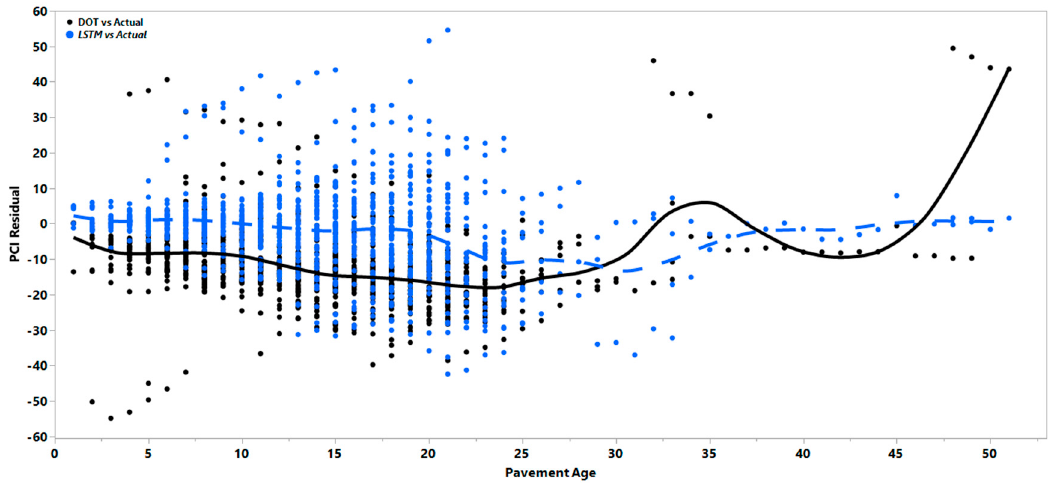
Figure 7. PCI residual vs. age in AC pavements.